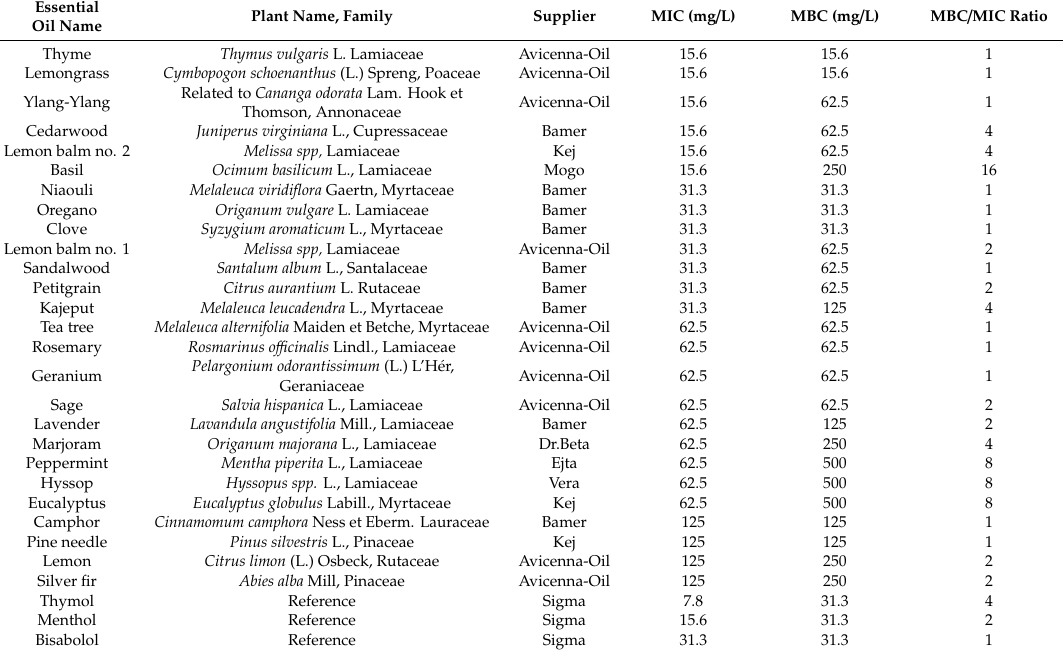
Table 1. Activity of 26 commercial essential oils against H. pylori ATCC 43504.